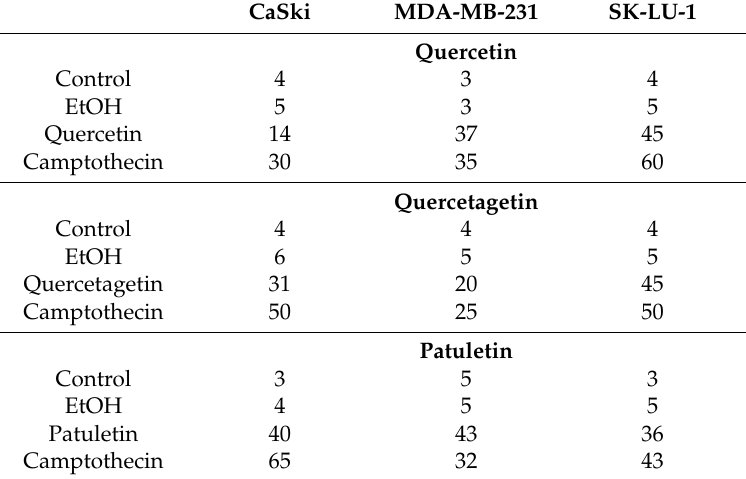
Table 3. Percentage of positive cells to active caspase-3 in cultures of CaSki, MDA-MB-231 and SK-Lu-1 cells treated with IC 50 values of quercetin, quercetagetin and patuletin.